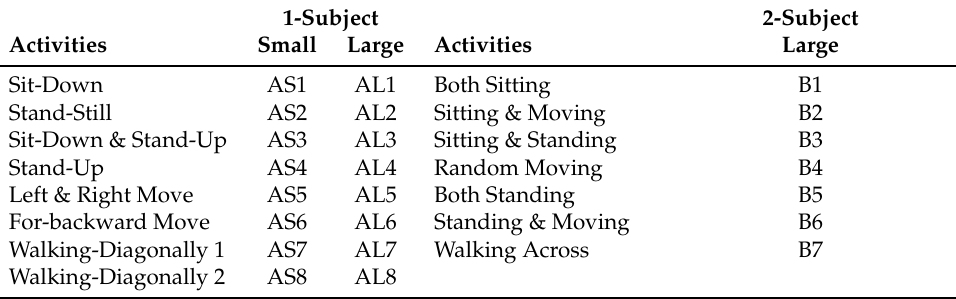
Table 1. Two categories of activities in the Coventry-2018